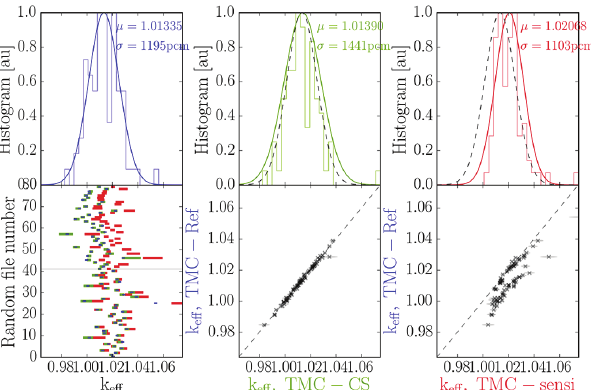
Fig. 7. See Figure 5 legend, applied to random cross section of Figure 6.